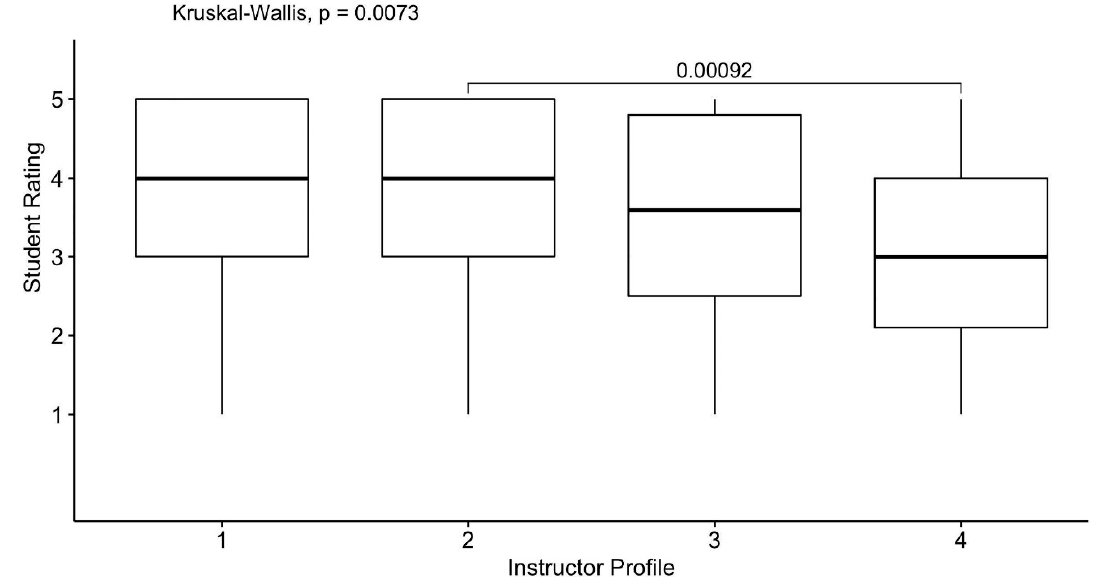
Figure 9. Ratings according to Online Heritage Spanish course type and instructor profile. Instructor 1 is a native speaker from Spain, Instructor 2 is a native speaker from Latin America, Instructor 3 is a Heritage Speaker of Spanish, and Instructor 4 is an L2 Spanish speaker.